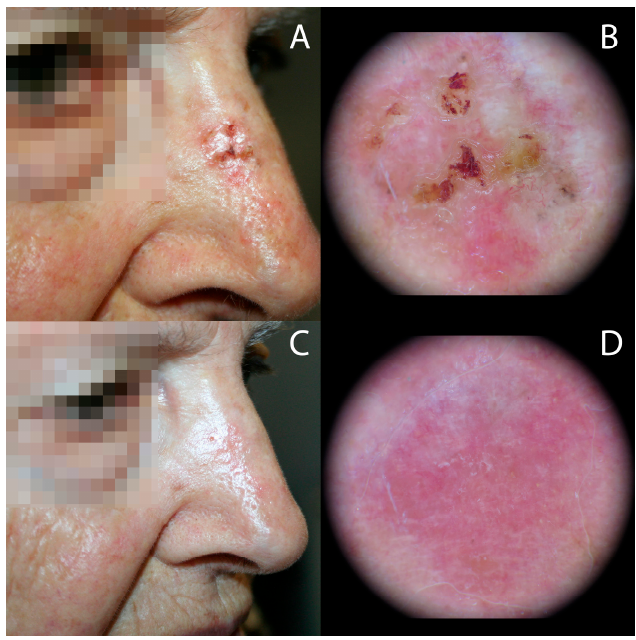
Figure 1. Superficial basal cell carcinoma (sBCC) at the right side of the nose treated with methyl aminolevulinate (MAL)-photodynamic therapy (PDT) using intense pulsed light (IPL) as light source. Clinical and dermoscopic images showing: ( A , B ) short fine telangiectasias, multiple small erosions located in a red structureless background and scales before treatment and ( C , D ) complete clinical and dermoscopic respone at six months follow-up. Cosmetic outcome was rated as excellent.